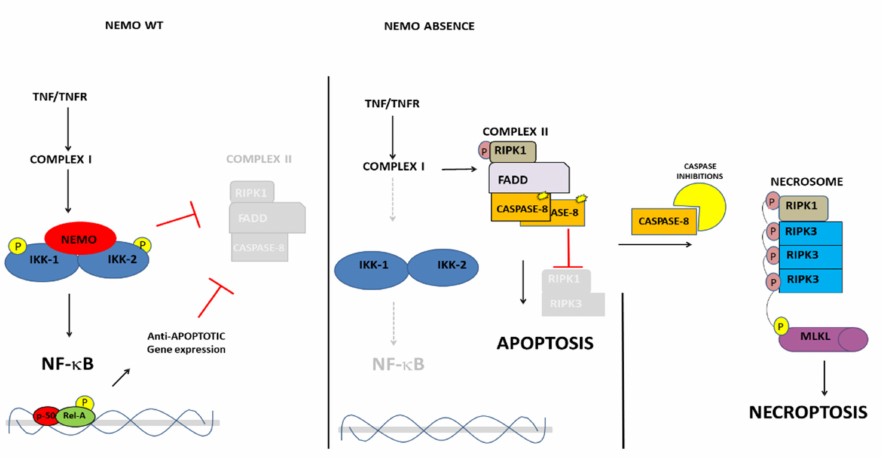
Figure 3. The model of anti-apoptotic NEMO activity and the different complexes formed upon TNFR engagement. In the presence of NEMO-WT (left panel) or in the absence of NEMO, apoptosis (central panel) and necroptosis (right panel)